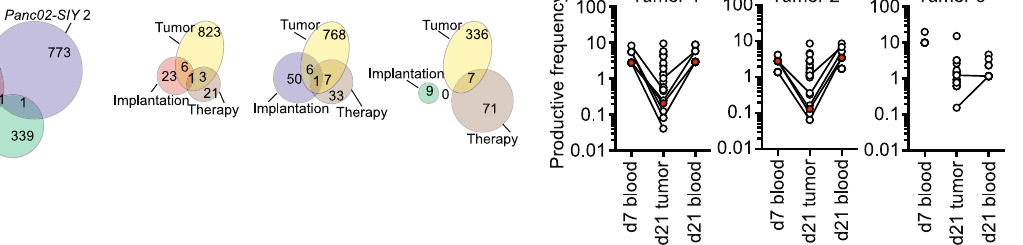
Figure 6. T cell responses generated by treatment are different from those generated by implantation. ( a ) i) Panc02-SIY tumors were implanted into wild-type mice or SIY + mice and treated with anti-PD1 on days 7 and 14 and RT on d14. Blood was harvested from groups on ii) d7 and iii) d21 for analysis of SIY-specific T cells in the peripheral blood using SIY-pentamers. ( b ) i) C57BL/6 mice were vaccinated with Lm-SIY on d0 and d14, and peripheral blood was harvested on d7 and d21. SIY-specific CD8 T cells were sorted from the peripheral blood based on SIY-pentamer binding and sorted cells underwent TCRSeq to identify SIY-responsive clones. ii) The number of distinct SIY-specific clones in each animal at d7 following vaccine priming is shown, along with shared clones. Circle areas are approximately to scale. iii) The number of clones shared within individual animals between prime (d7) and boost (d21). Circle areas are approximately to scale. ( c ) i) Panc02-SIY tumors were implanted into C57BL/6 mice and treated with anti-PD1 on days 7 and 14 and RT on d14. Blood was harvested from mice on d7 and d21 and on d21 the tumor was also harvested. SIY-specific CD8 T cells were sorted from the peripheral blood based on SIY-pentamer binding and sorted cells underwent TCRSeq to identify SIY-responsive clones. ii) The number of distinct SIY-specific clones in each animal at d7 following vaccine priming is shown, along with shared clones. Circle areas are approximately to scale.0 iii) The number of clones shared within individual animals generated following implantation (d7) and treatment (d21). Circle areas are approximately to scale. ( d ) i)The number of distinct clones identified following TCRSeq of unfractionated tumors harvested at d21 is shown, along with shared clones. Circle areas are approximately to scale. ii) The number of clones shared between the tumor and those in the peripheral blood following implantation and following treatment. Circle areas are approximately to scale, but tumors are not shown to scale. iii) The top 20 most abundant clones in the peripheral blood at d7 and d21, and the top 20 most abundant clones in the tumor at d21 are shown. Lines linking symbols denote shared clones. Clones highlighted in red are found in all three samples. Key: NS = not significant, * p < 0.05; ** p < 0.01; *** p < 0.001; **** p <